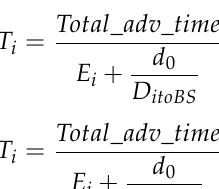
Figure 5. Data transmission Phase.